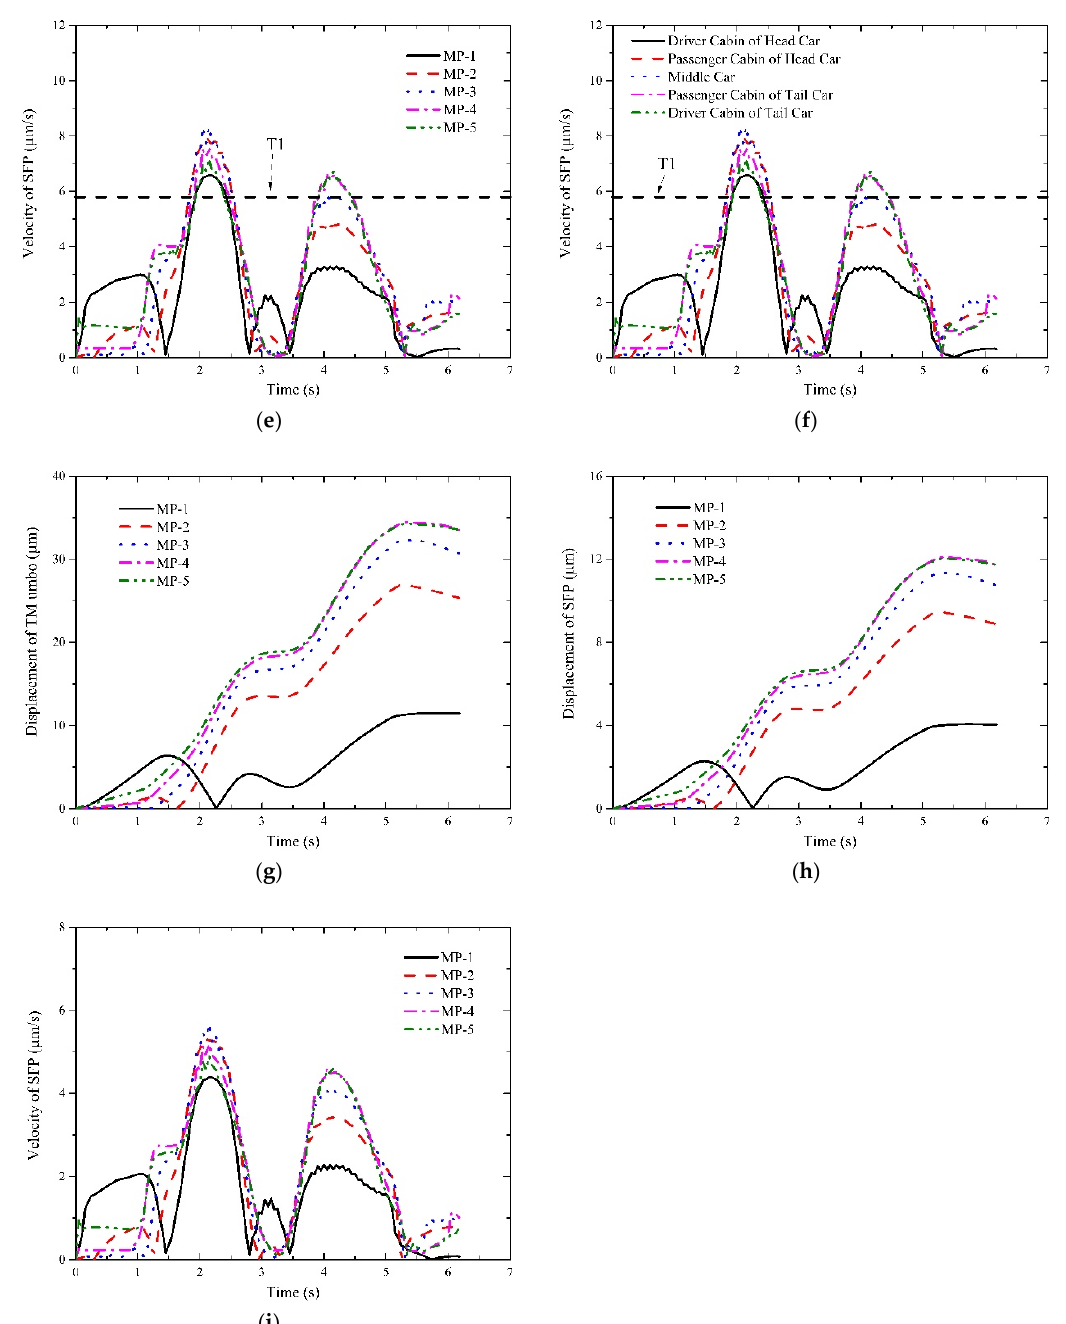
Figure 6. Responses of the indicators of interest at 250 km/h. ( a ) responses of I1 under a seal index of 4 s; ( b ) responses of I2 under a seal index of 4 s; ( c ) responses of I3 under a seal index of 4 s; ( d ) responses of I1 under a seal index of 8 s; ( e ) responses of I2 under a seal index of 8 s; ( f ) responses of I3 under a seal index of 8 s; ( g ) responses of I1 under a seal index of 12 s; ( h ) responses of I2 under a seal index of 12 s; ( i ) responses of I3 under a seal index of 12 s.